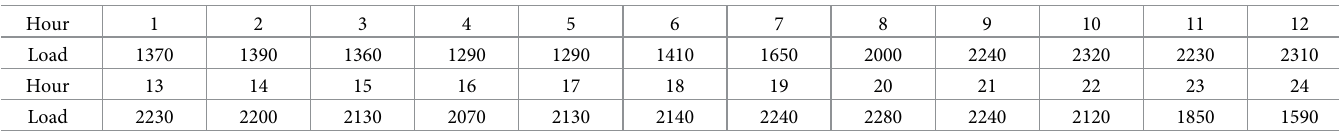
Table 1. The system daily hourly loads